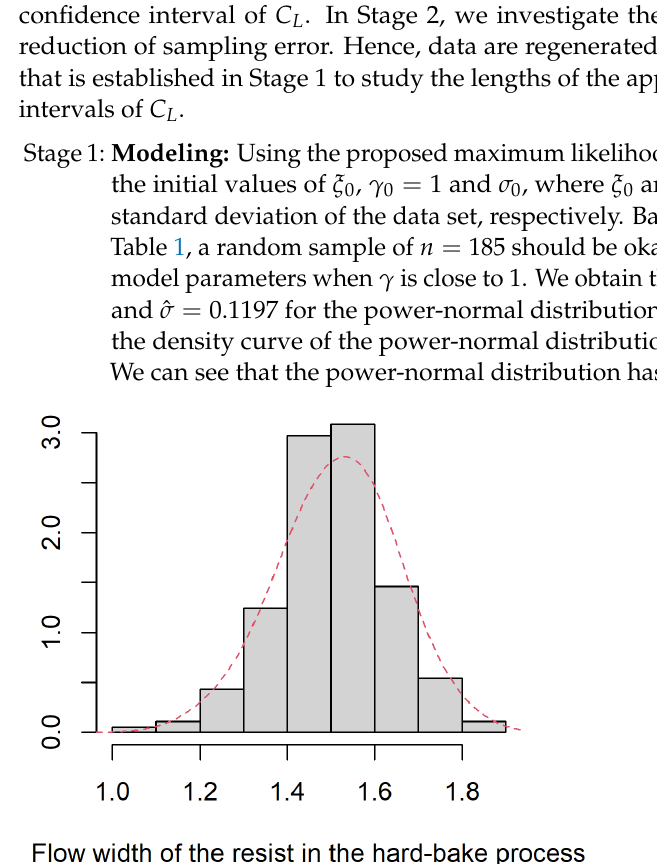
Figure 2. The histogram of the flow width data in Example 1. The quantile-to-quantile plot based on the flow width data and the power-normal distribution is presented in Figure 3. All the dots are plotted around the straight line. Hence, the quantile-to-quantile plot indicates that the power-normal distribu- tion can be the right model to characterize the flow width data. The test statistic of the Kolmogorov-Smirnov test based on the flow width data and power-normal distribution is 0.062 with the p -value of 0.2917. Based on the Kolmogorov-Smirnov test, we conclude that the power-normal distribution can be a good model to char- acterize the flow width data. Because the MLE of the shape parameter, ˆ γ =